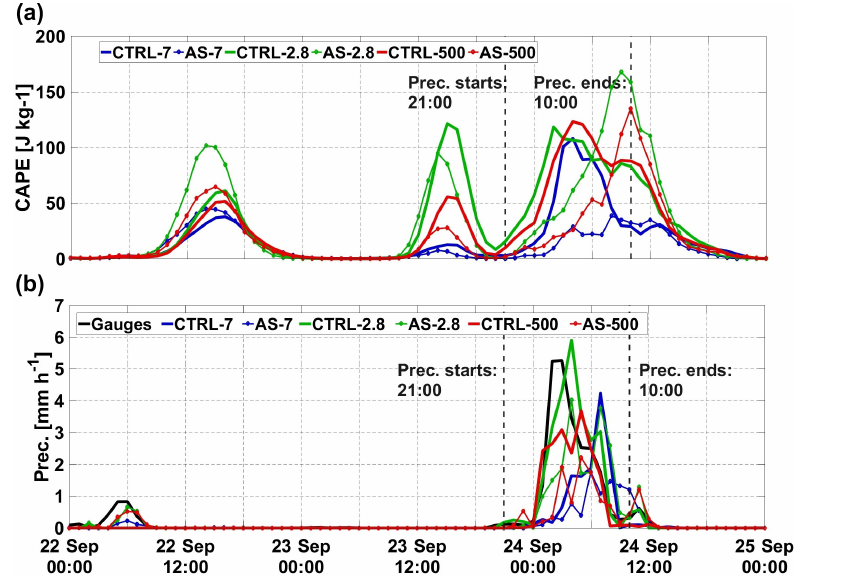
Figure 4. Spatial averages temporal evolution over area A1. (a) CAPE and (b) precipitation from rain gauges and COSMO at the nearest grid